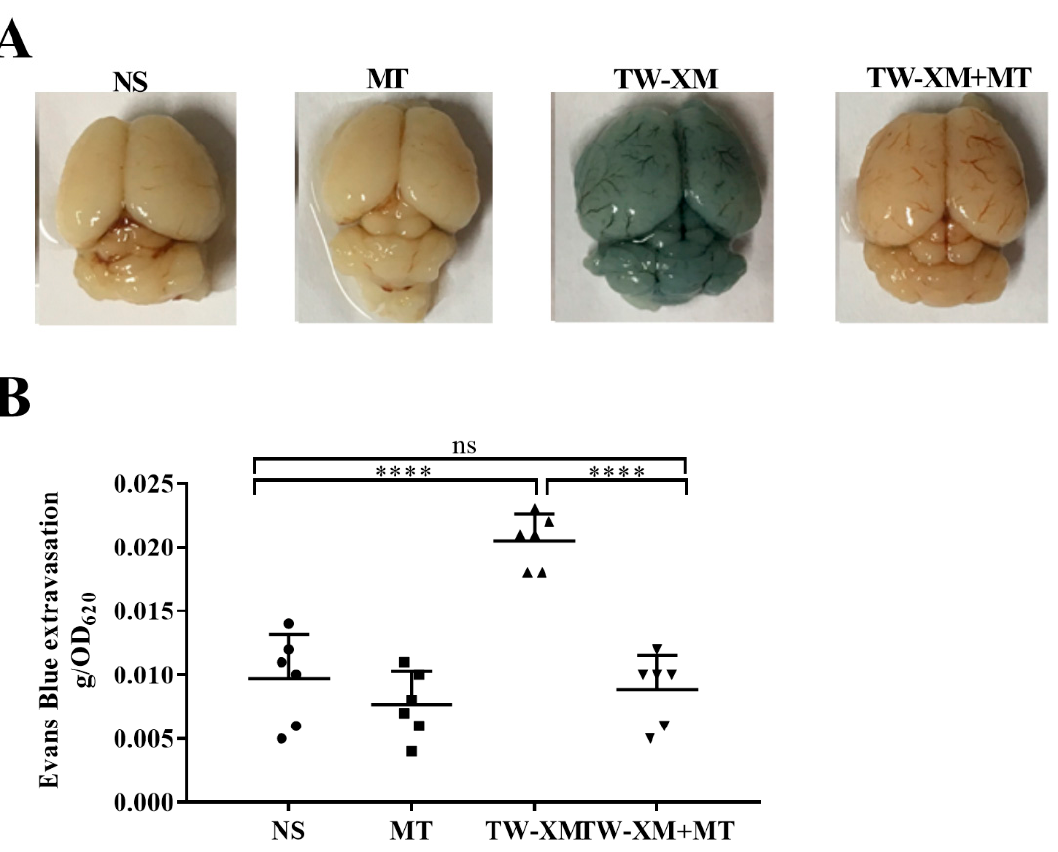
Figure 2. The effect of melatonin on the BBB integrity in APEC TW − XM − infected mice. ( A , B ) The BBB integrity was analyzed qualitatively and quantitatively by Evans blue infiltration assay. All data were determined by one − way ANOVA and expressed as means ± SEM. * p < 0.05, ** p < 0.01, *** p < 0.001, **** p < 0.0001, ns p > 0.05.